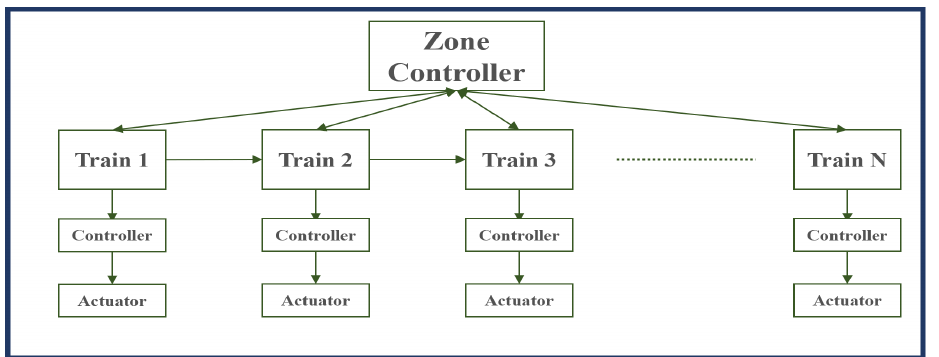
Figure 1. Communication structure between trains in VC.